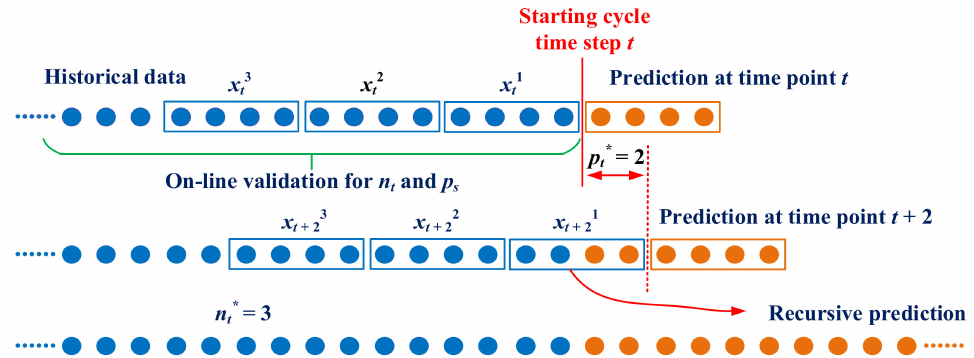
Figure 10. Moving sliding window scheme for RUL prediction (“*” is a special symbol that is used to characterize new values different from p and n